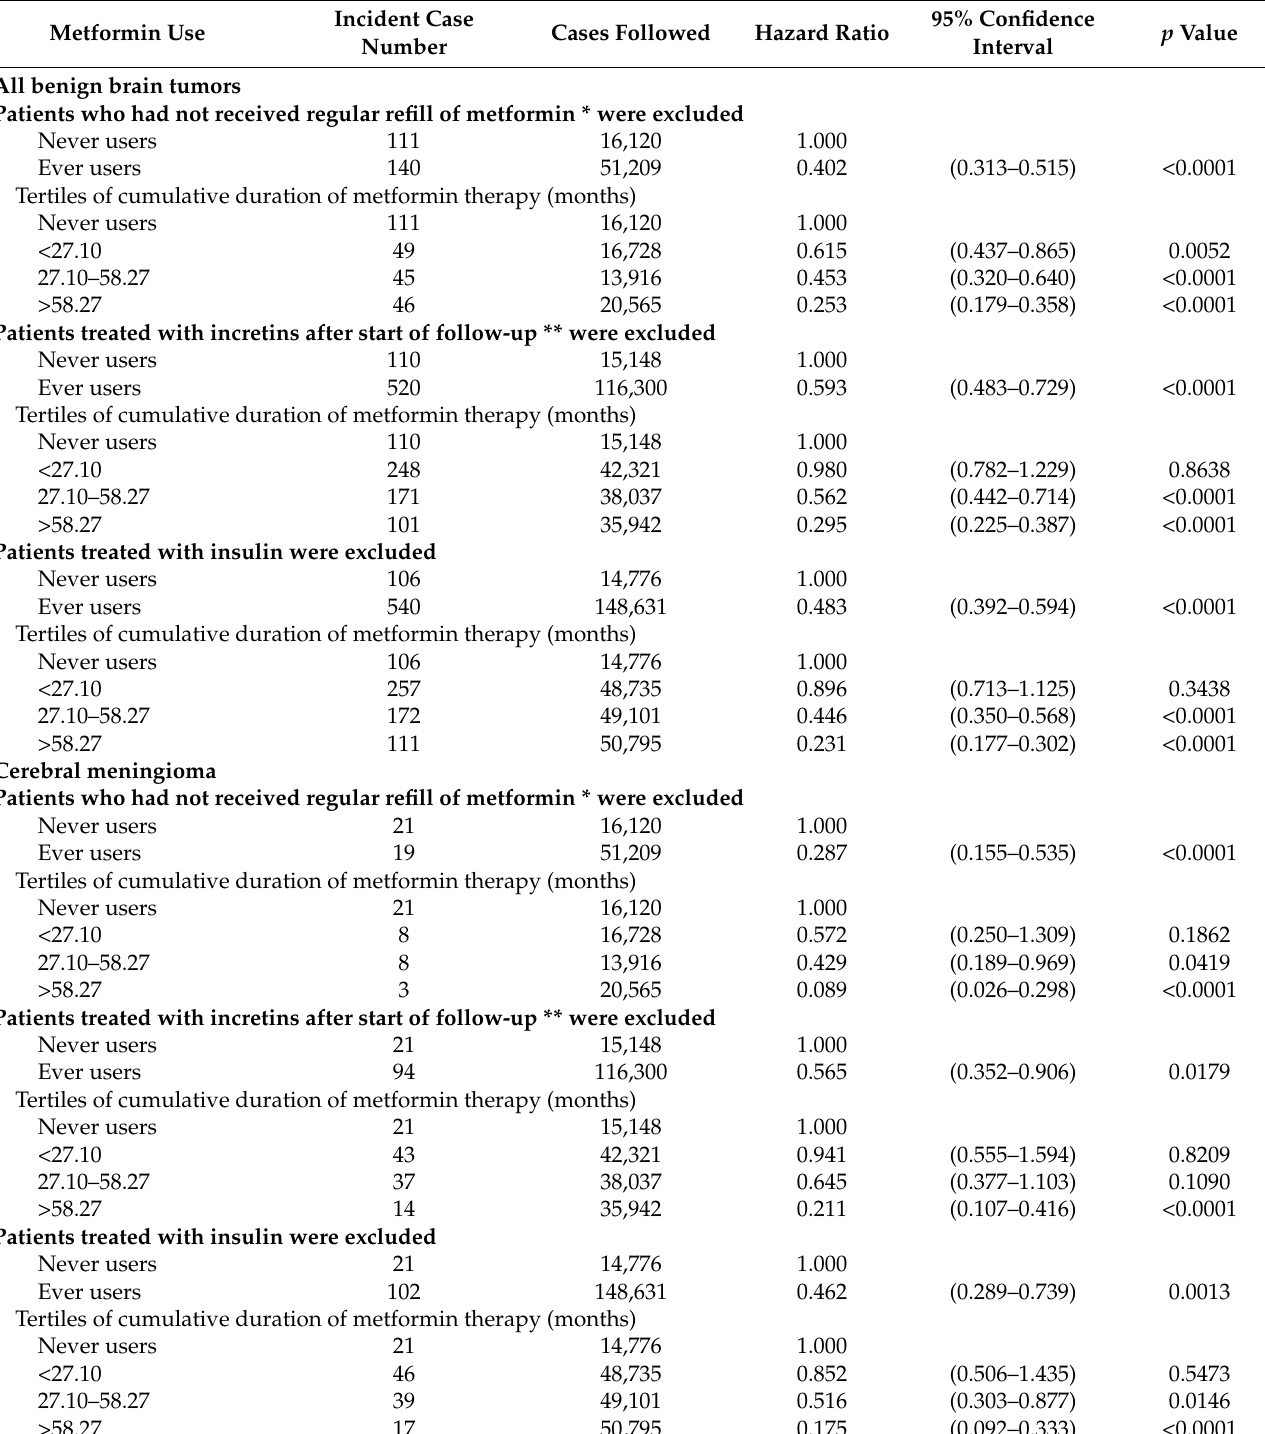
Table 3. Sensitivity